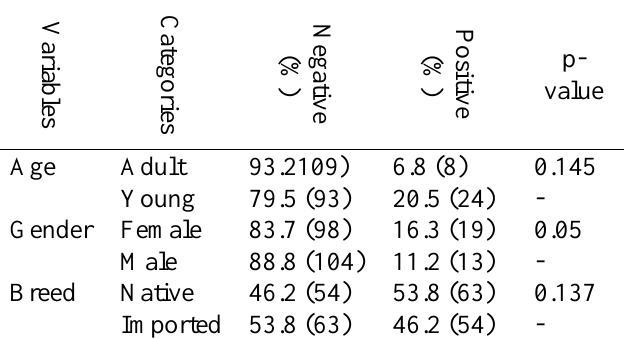
Table 1: Age, breed, and gender-based incidence of Borrelia burgdorferi in serum of stray dogs